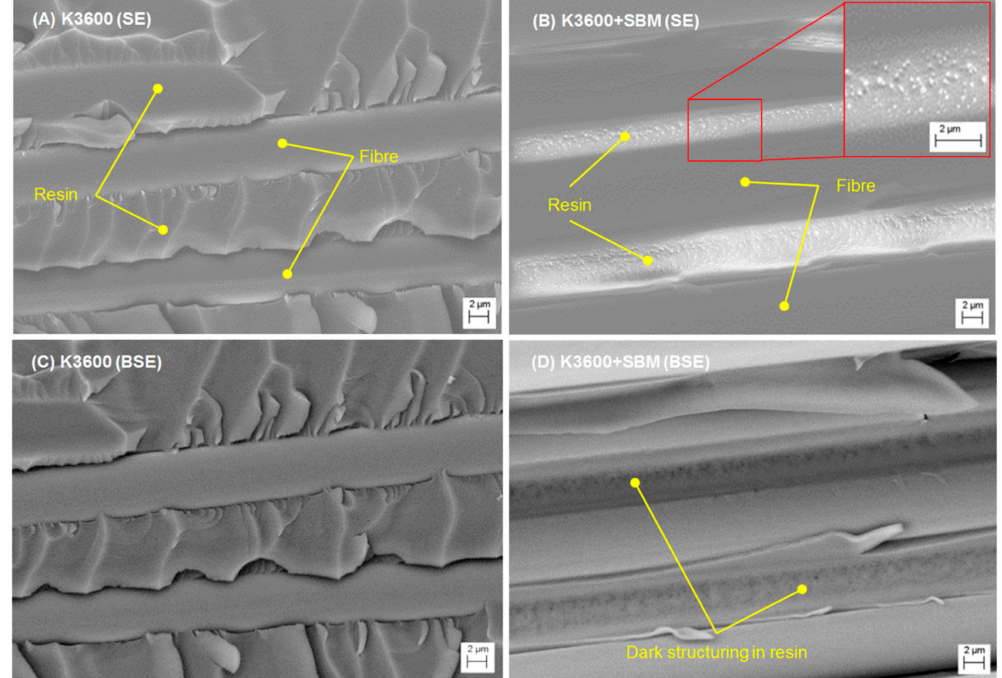
Figure 13. SEM images of Neat ( A , C ) and SBM-toughened ( B , D ) fracture surfaces excised from the specimens slightly ahead of the final crack tip length. ( A , B ) show results from the in-lens secondary electron (SE) detector of the field emission scanning electron microscope (FESEM) while ( C , D ) show the results from a backscattered electron (BSE)